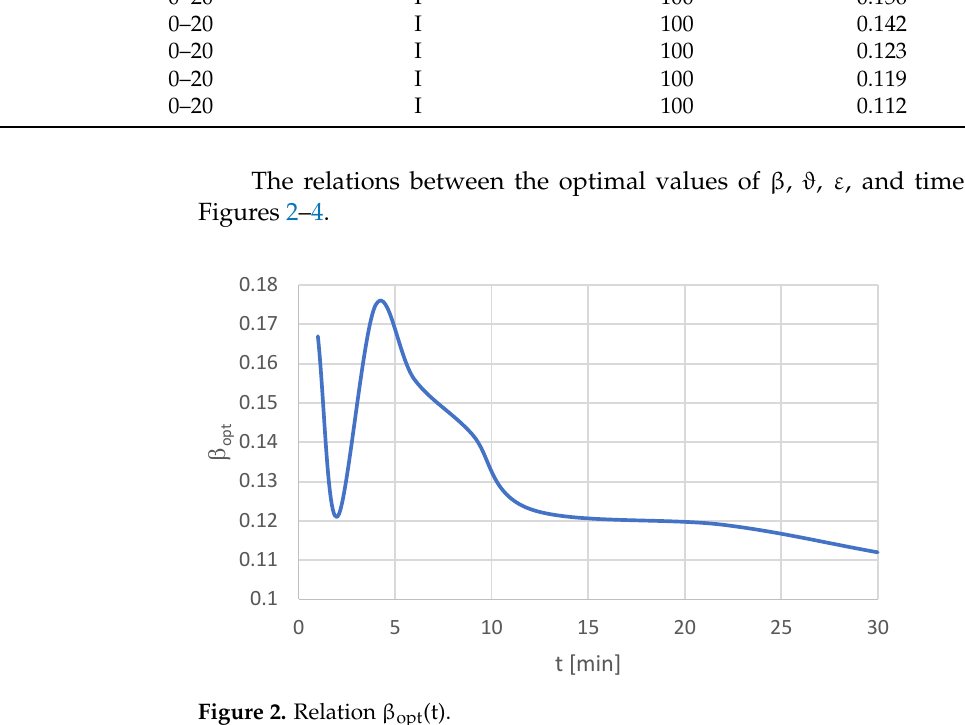
Figure 2. Relation β opt (t).